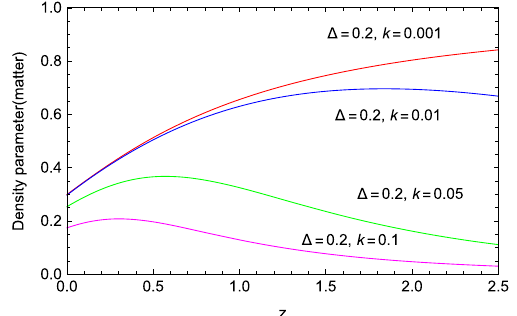
Fig. 2 Evolution of matter density parameter, as a function of redshift z , for Δ = 0 . 2 and C = 3 , in unit of M 2 p = 1 . The line corresponds: red: k = 0 . 001 ; blue: k = 0 . 01 ; green: k = 0 . 05 ; magenta: k = 0 . 1